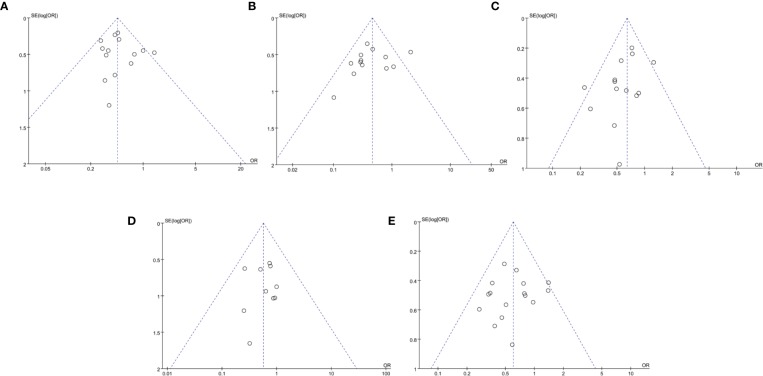
Publication bias plot for myelosuppression. (A) Publication bias plot for the decline of leukocyte counts (I–IV). (B) Publication bias plot for the decline of leukocyte counts (III–IV). (C) Publication bias plot for the decline of hemoglobin counts (I–IV). (D) Publication bias plot for the decline of hemoglobin counts (III-IV). (E) Publication bias plot for the decline of platelet counts (I–IV).